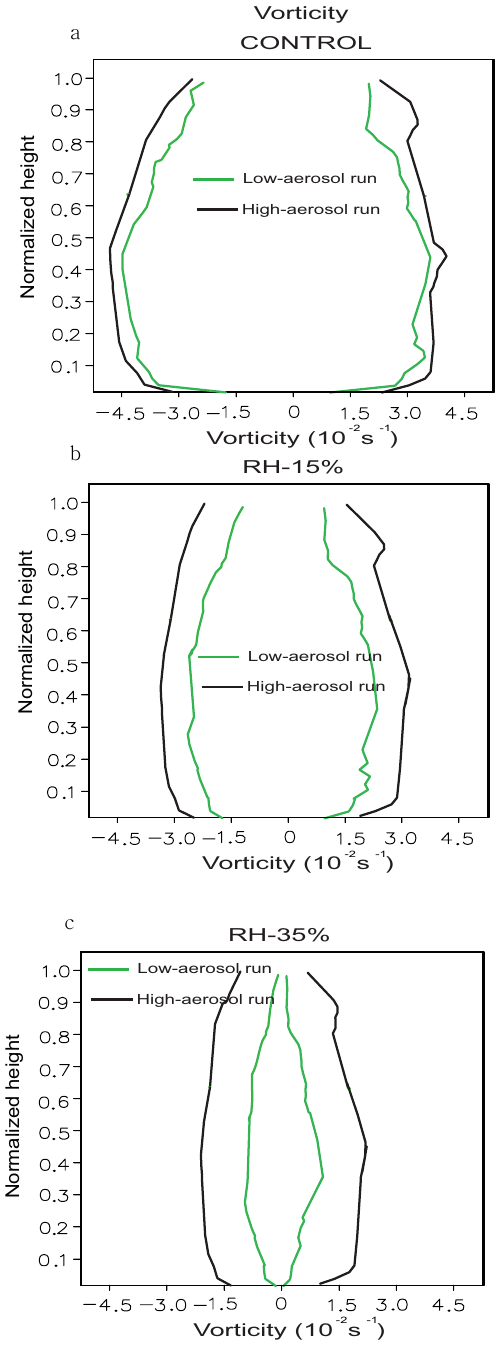
Fig. 9. Normalized profiles of the horizontal vorticity (positive and negative) for the high- and low-aerosol runs in (a) CONTROL, (b) RH-15%, and (c)